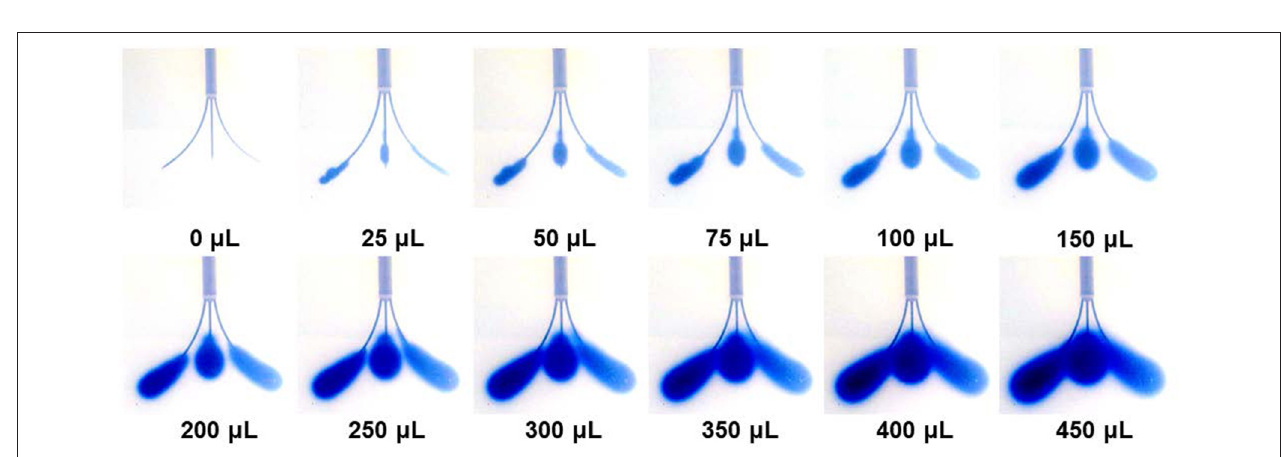
FIGURE 4 | AAV compatibility tests. (A) AAV concentration before and after CED through MINT at 3, 5, and 10 µ L/min. D1, D2, and D3 denote 1:1000, 1:5000, and 1:25000 AAV dilutions, respectively (* p < 0.05 compared to initial titer by Sidak post-hoc multiple comparisons analysis). (B) Change in AAV concentration after CED through MINT. Each point represents the average of n = 3 repeats in each trial. Horizontal line shows mean, error bar is the standard deviation.